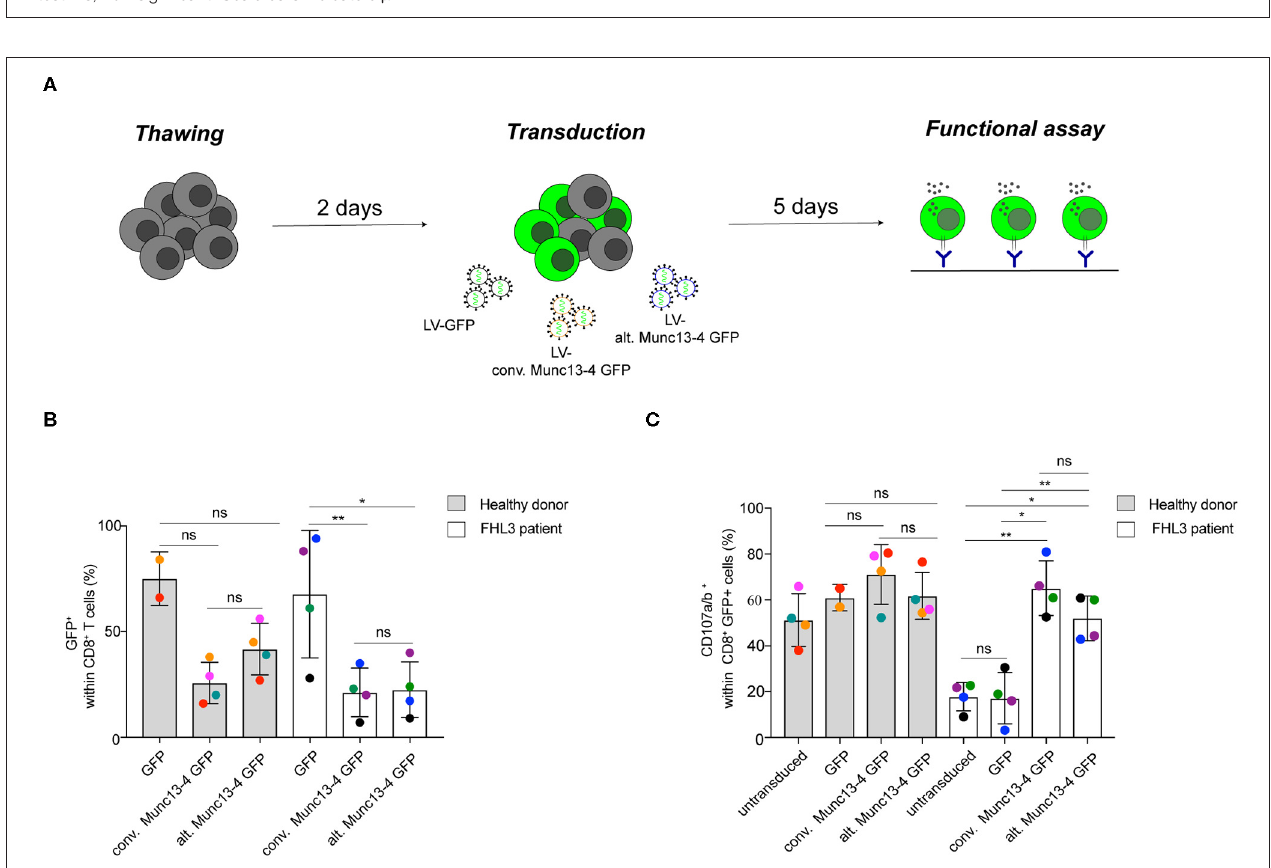
FIGURE 4 | (D) TIRF microscopy of cytotoxic CD8 + T cells from healthy donors transfected with Granzyme B-TFP and conventional (top) or alternative (bottom) Munc13-4-mCherry. Images show the recruitment of specific Munc13-4 isoforms together with cytotoxic granules to the interface with anti-CD3 mAbs coated coverslips. (E) The histogram shows the quantification (%) of cells harboring Munc13-4 in the TIRF plane. Accumulated data from five healthy donors are depicted (different colors represent individual donors). An average of 32 cells were analyzed for each donor. Bars depict mean ± SD. P -values were calculated using a paired T -test. ns, non-significant. Scale bars indicate 5 µ m.